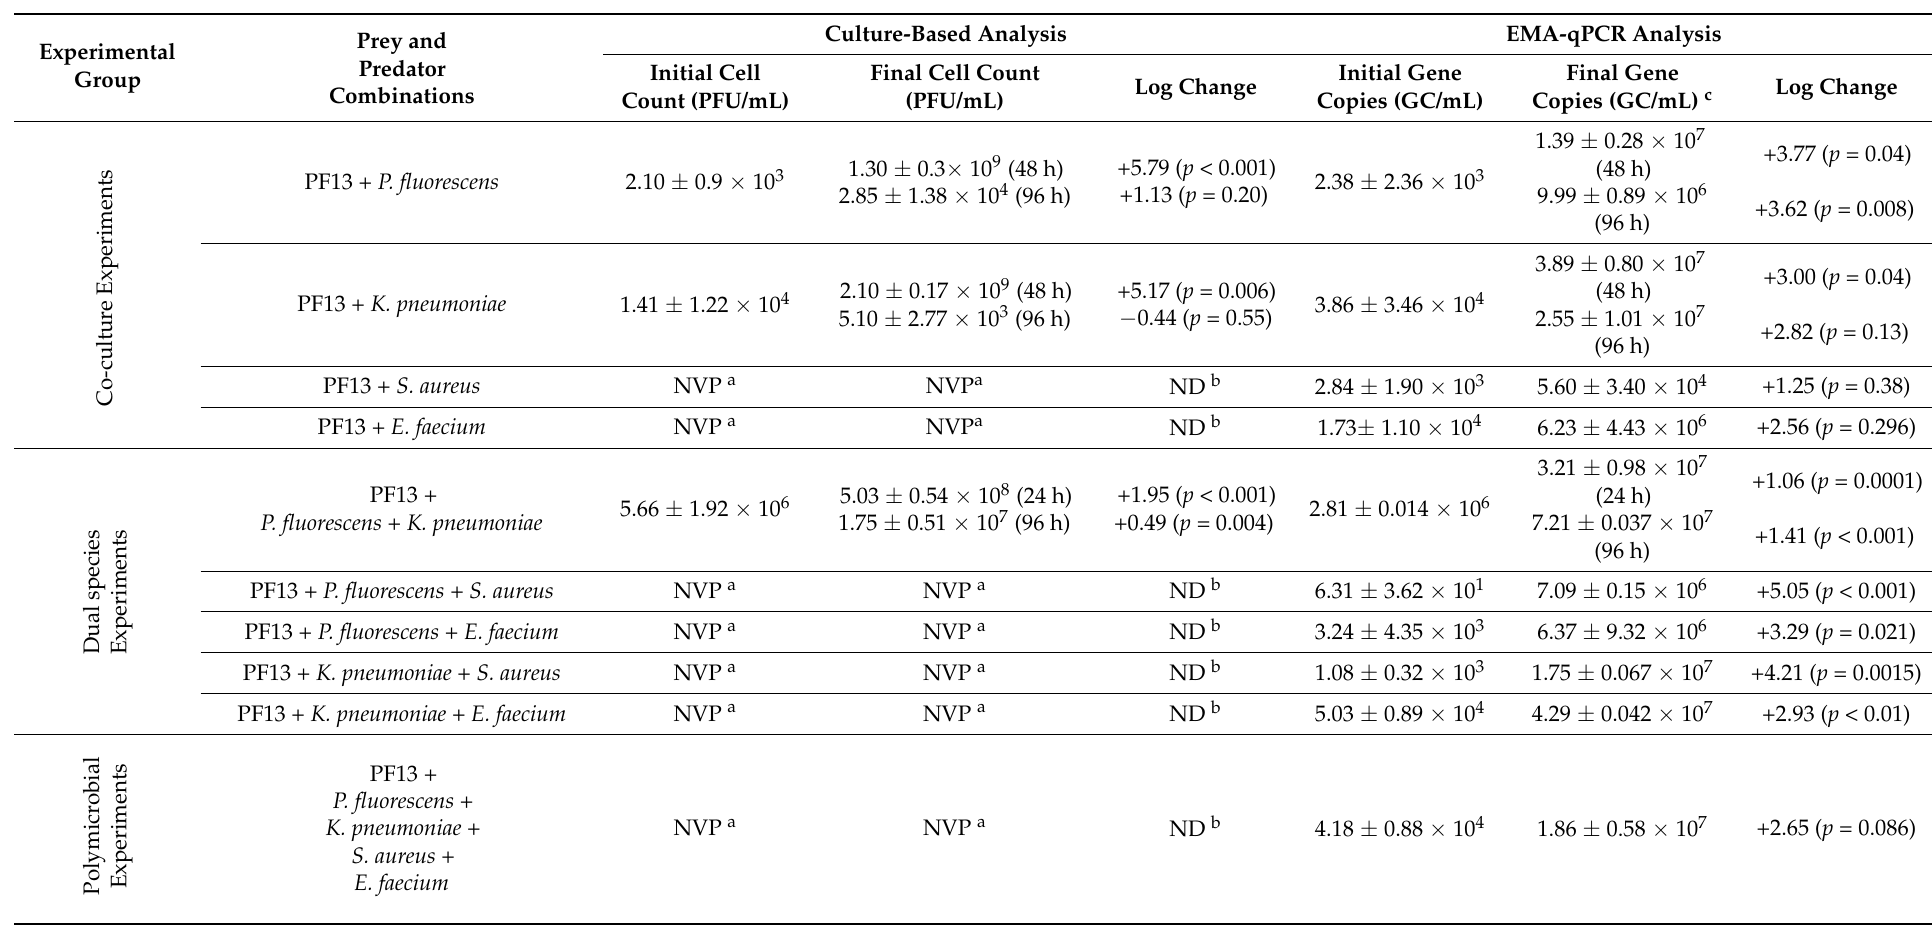
Table 1. Cell counts and gene copies ( ± standard deviation) of B. bacteriovorus PF13 in the co-culture, dual species and polymicrobial experiments.